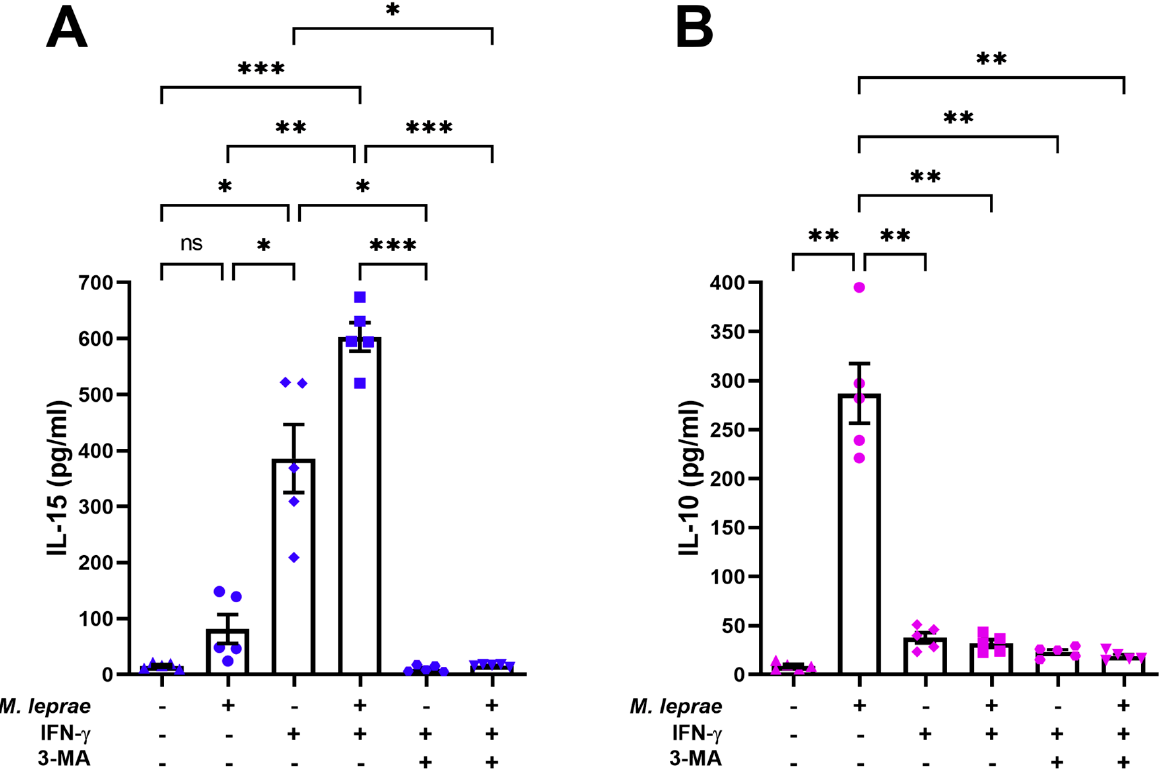
Figure 4. In the presence of M. leprae , IFN- γ increased the secretion of IL-15 in THP-1 macrophages. THP-1 macrophages were pretreated or not with 10 mM 3-MA for 1 h, stimulated with M. leprae for 30 min (MOI 10:1), and treated with 10 ng/mL of IFN- γ for 18 h. Cytokine production was assessed by ELISA. ( A ) IL-15, ( B ) IL-10. The graphs are representative of five experiments. Data are the mean ± S.E.M; * p < 0.05, ** p < 0.01, *** p < 0.001 by the repeated measures one-way ANOVA with the Geisser-Greenhouse correction and Tukey’s multiple comparisons test. ns: not significant.